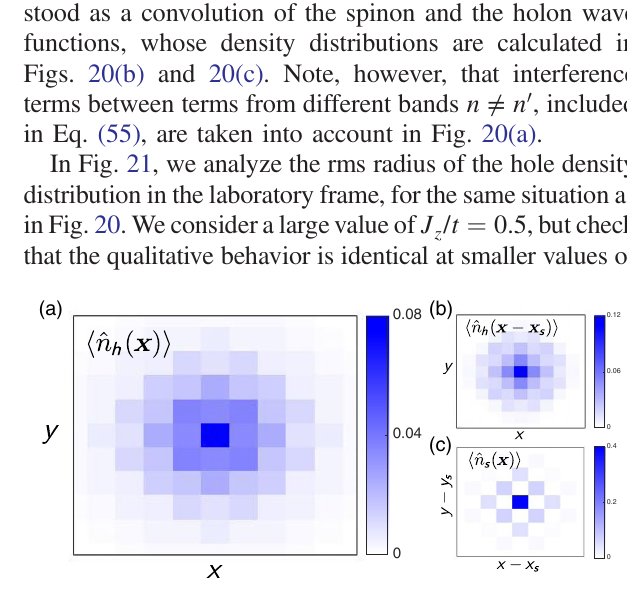
x Þi FIG. 20. The hole distribution in the laboratory frame h ˆ n h ð (a) is obtained as a convolution of the spinon and holon wave functions. We consider far-from-equilibrium dynamics of a single hole in the t - J model, which is initially localized in the center. z The results are shown at a time of 50 / t and J / t ¼ 0.5 was chosen. z Our calculations are performed within LST for S ¼ 1 /2 and 30 . In (b) the holon assuming a maximum string length of l max ¼ distribution h ˆ n ð x − x in the spinon frame is shown, and in s Þi (c) the spinon density in the laboratory frame is shown at the same final time 50 / t .